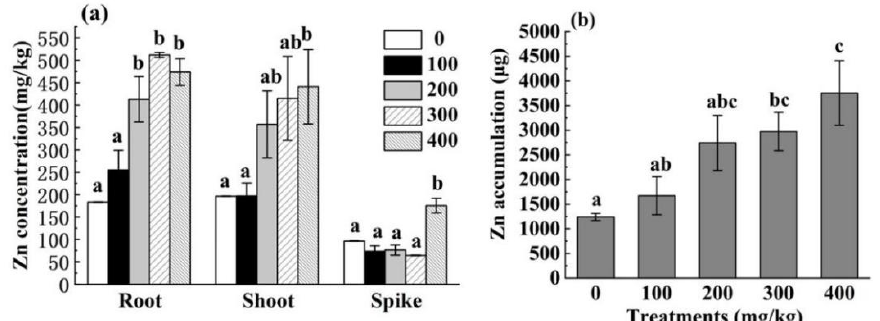
Figure 4. Zn concentrations of all parts of the sea rice ( a ) and its Zn accumulation ( b ). Lowercase letters on the bar chart indicate significant differences among different treatments ( p < 0.05). Data were presented as mean ± standard error (n = 3).